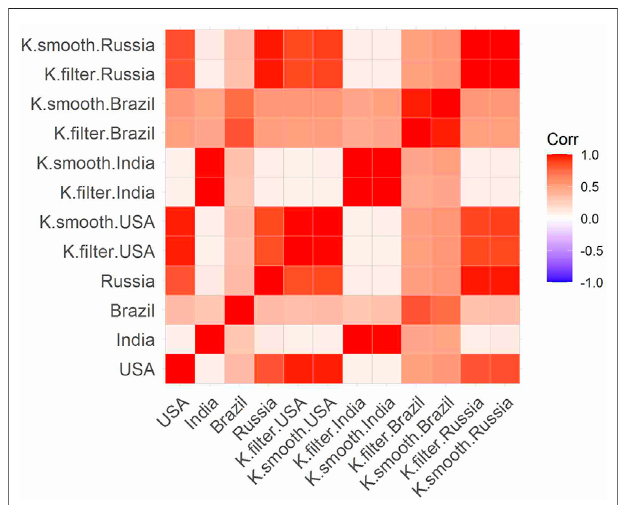
FIGURE13| Heat-map Correlationplotforthedailycon fi rmedcases for United States, India, Brazil, and Russia.